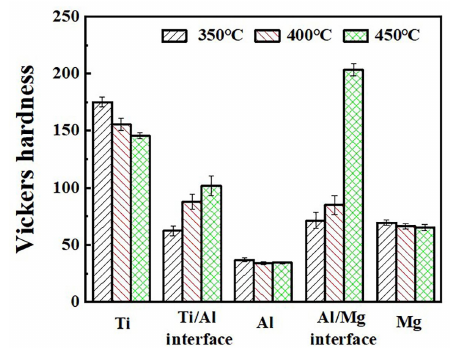
Figure 9. The micro-hardness values of Ti layer, Ti/Al interface, Al layer, Al/Mg interface and Mg layer in LMCs fabricated at different hot-pressing temperatures.